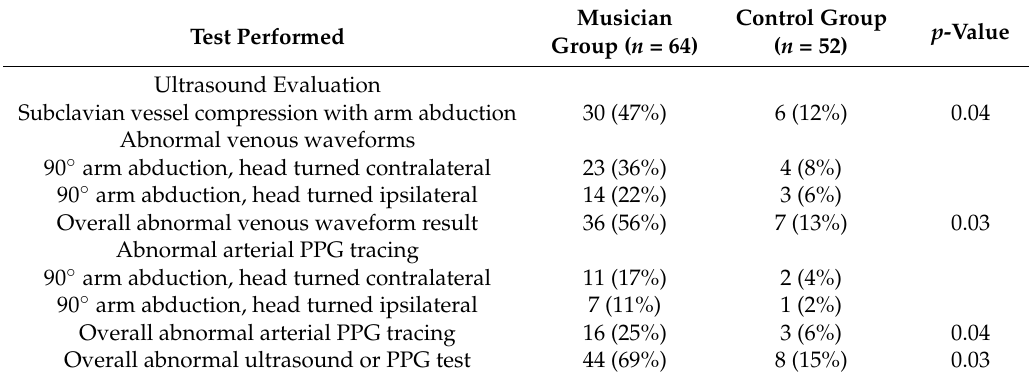
Table 4. Comparison of ultrasound and PPG evaluation between the musician and control groups.